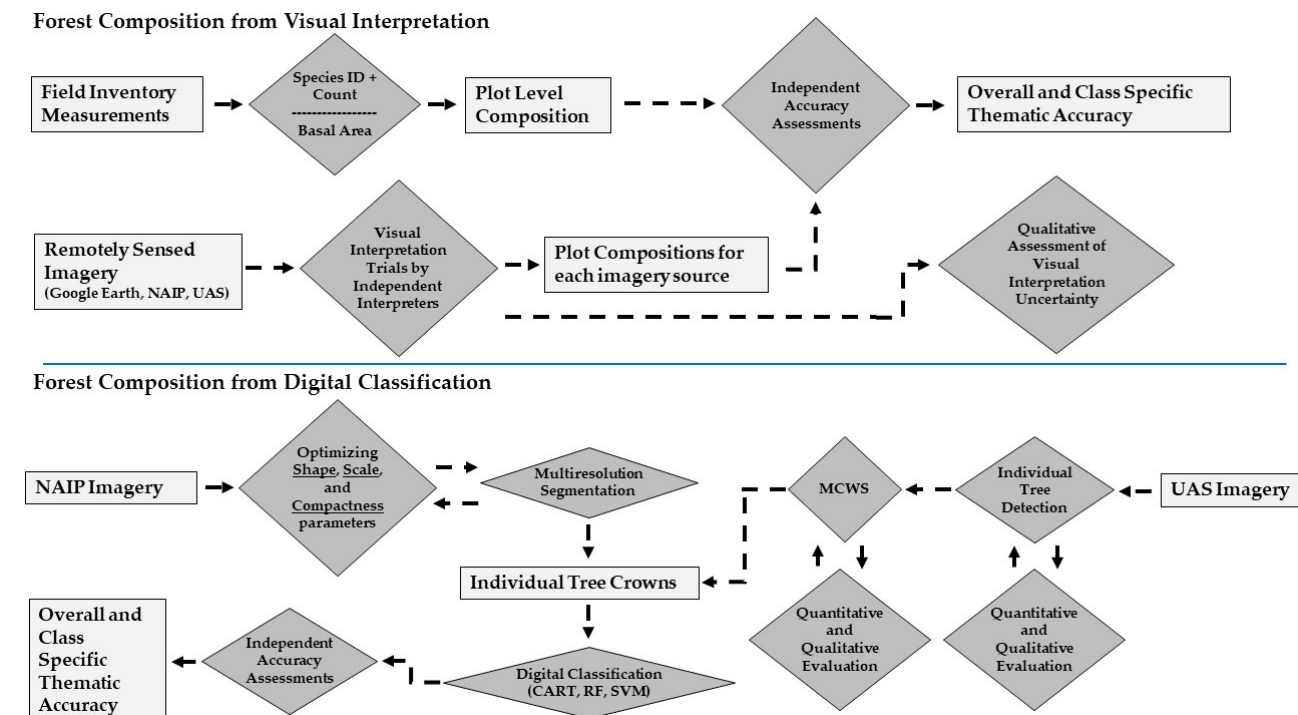
Figure 3. Flow chart outlining the methodology used for the visual interpretation and digital classification assessments of fine-scale forest composition.